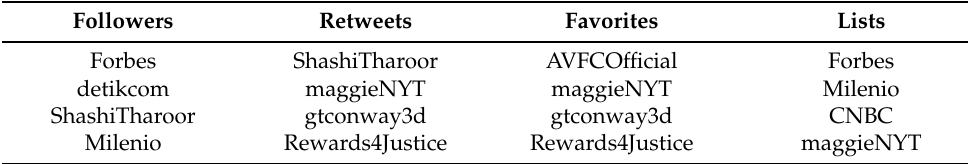
Table 3. Top-4 ranked users for different features.